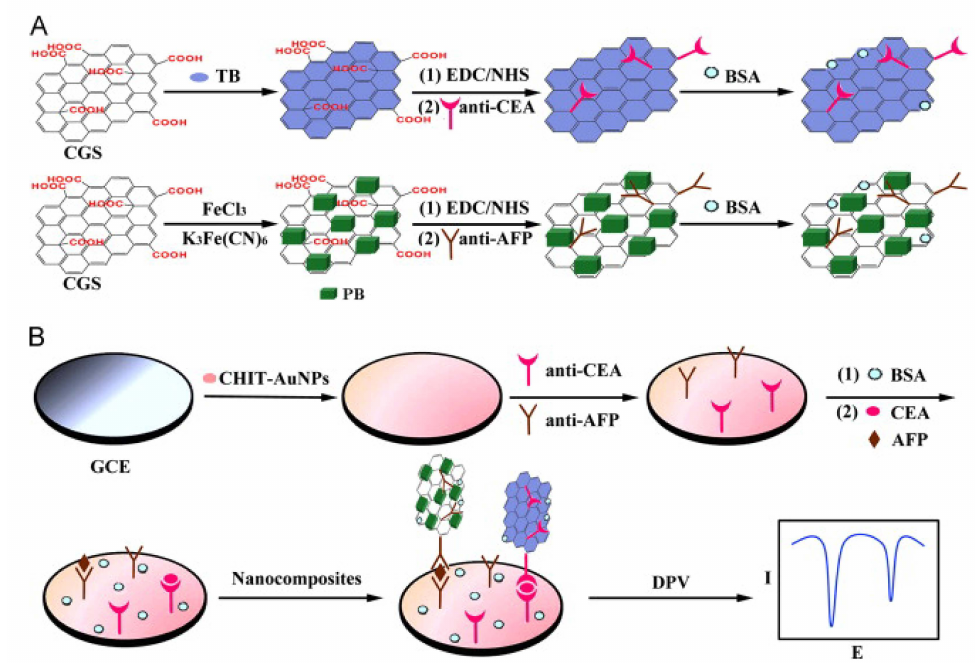
Figure 2. ( A ) The separate preparation of TB, CEA, and AFP type antibody-carrying carboxyl graphene nanosheets (CGS). ( B ) Process steps in the detection strategy of the developed biosen- sor; Chitosan and gold nanoparticle modification, capture antibody immobilization, blocking with BSA, incubation with specific antigens, interaction with biofunctional CGS nanocomposites, and measurement by DPV method. Reprinted with permission from Ref. [81]. Copyright 2013,